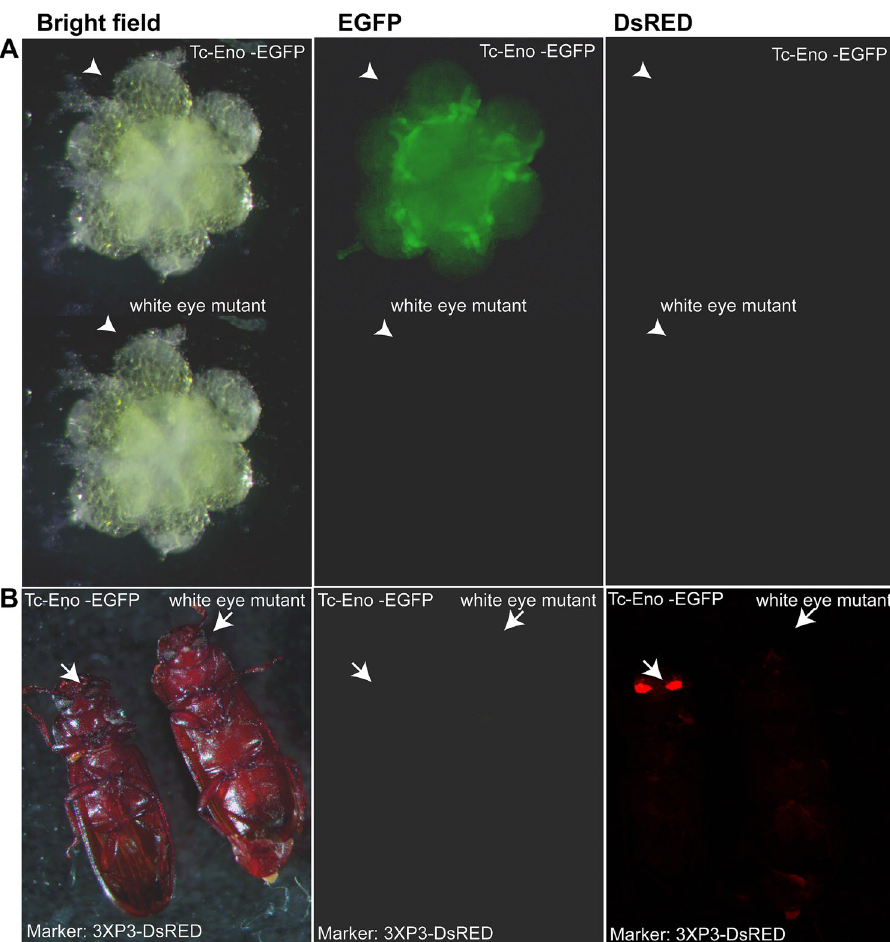
Figure 6. Tc -eno regulatory regions drive EGFP expression in testes. ( A ) Testes from transgenic beetles (upper right) and non-transgenic beetles (lower left) viewed under bright field, EGFP or DsRED filters. ( B ) Adult transgenic (left) and non-transgenic (right) viewed under bright field, EGFP or DsRED filters. Arrows indicate the eyes and testes where DsRED and EGFP expression respectively were expected for transgenic Tc-Eno- EGFP#1 line